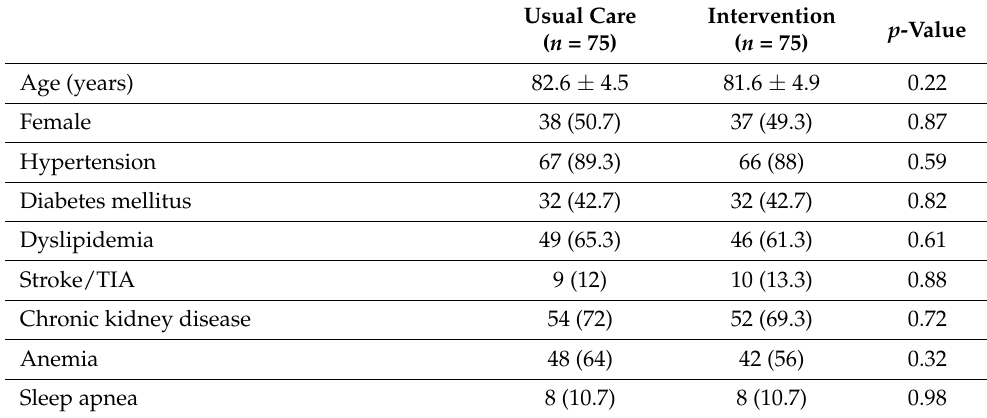
Figure 1. Flow diagram of the study. Table 1. Baseline characteristics and medication at hospital discharge of the patients included in the